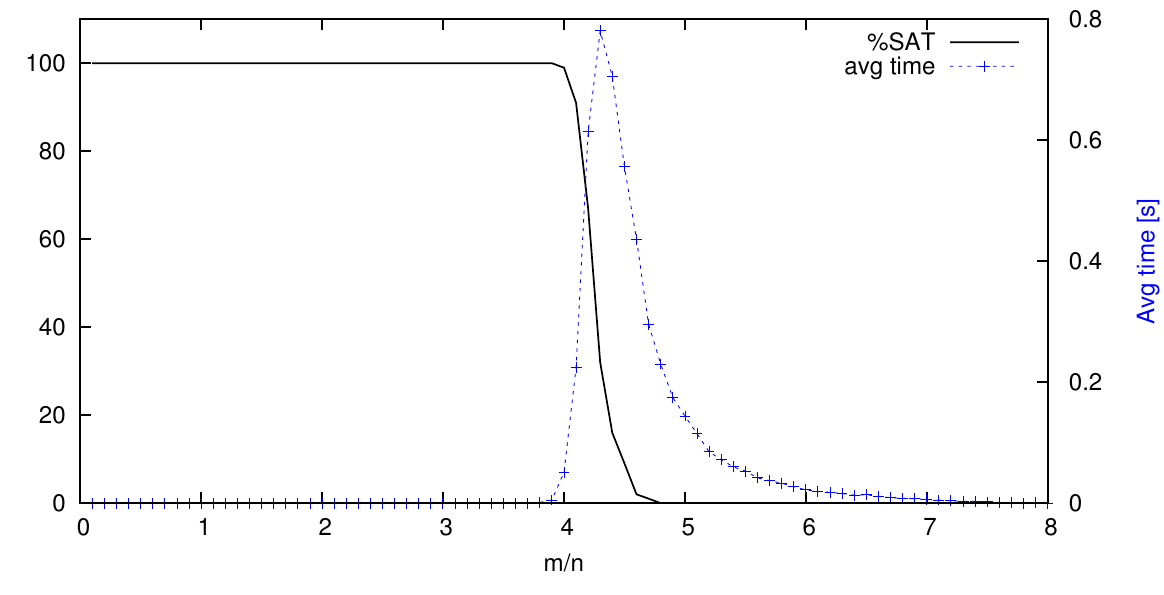
Figure 1. SAT Empirical Complexity Profile, n = 200